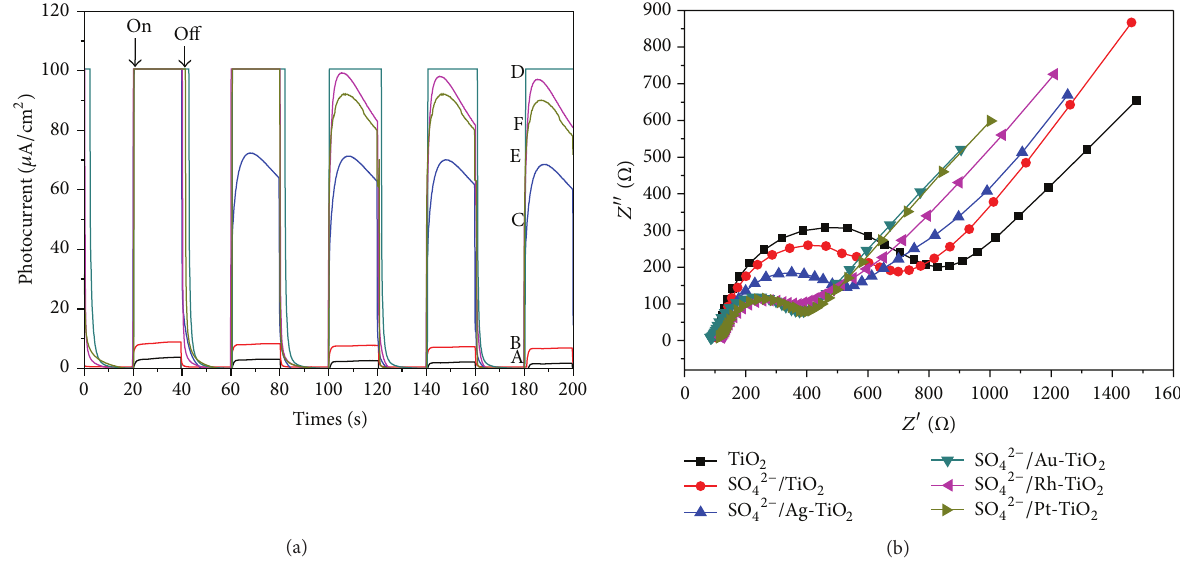
Figure 7: (a) Transient photocurrent response of (A) TiO 2 , (B) SO 42− /TiO 2 , (C) SO 42− /Ag-TiO 2 , (D) SO 42− /Au-TiO 2 , (E) SO 42− /Rh-TiO 2 , and (F) SO 42− /Pt-TiO 2 samples under intermittent UV light irradiation; (b) EIS of samples.